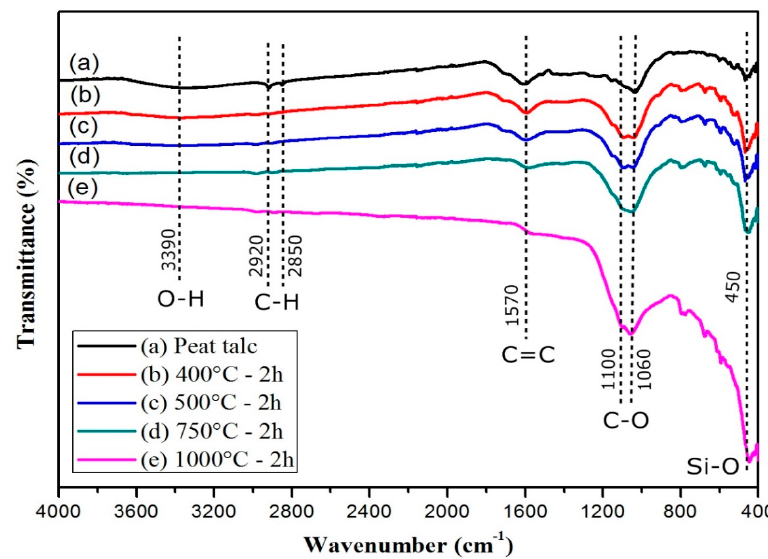
Figure 4. Absorption spectroscopy on the infrared range (FTIR), medium range for the peat talc and portions of the same sample undergoing different calcination temperatures: ( a ) peat “ in natura ”, ( b ) 400 °C, ( c ) 500 °C, ( d ) 750 °C, and ( e ) 1000 °C.